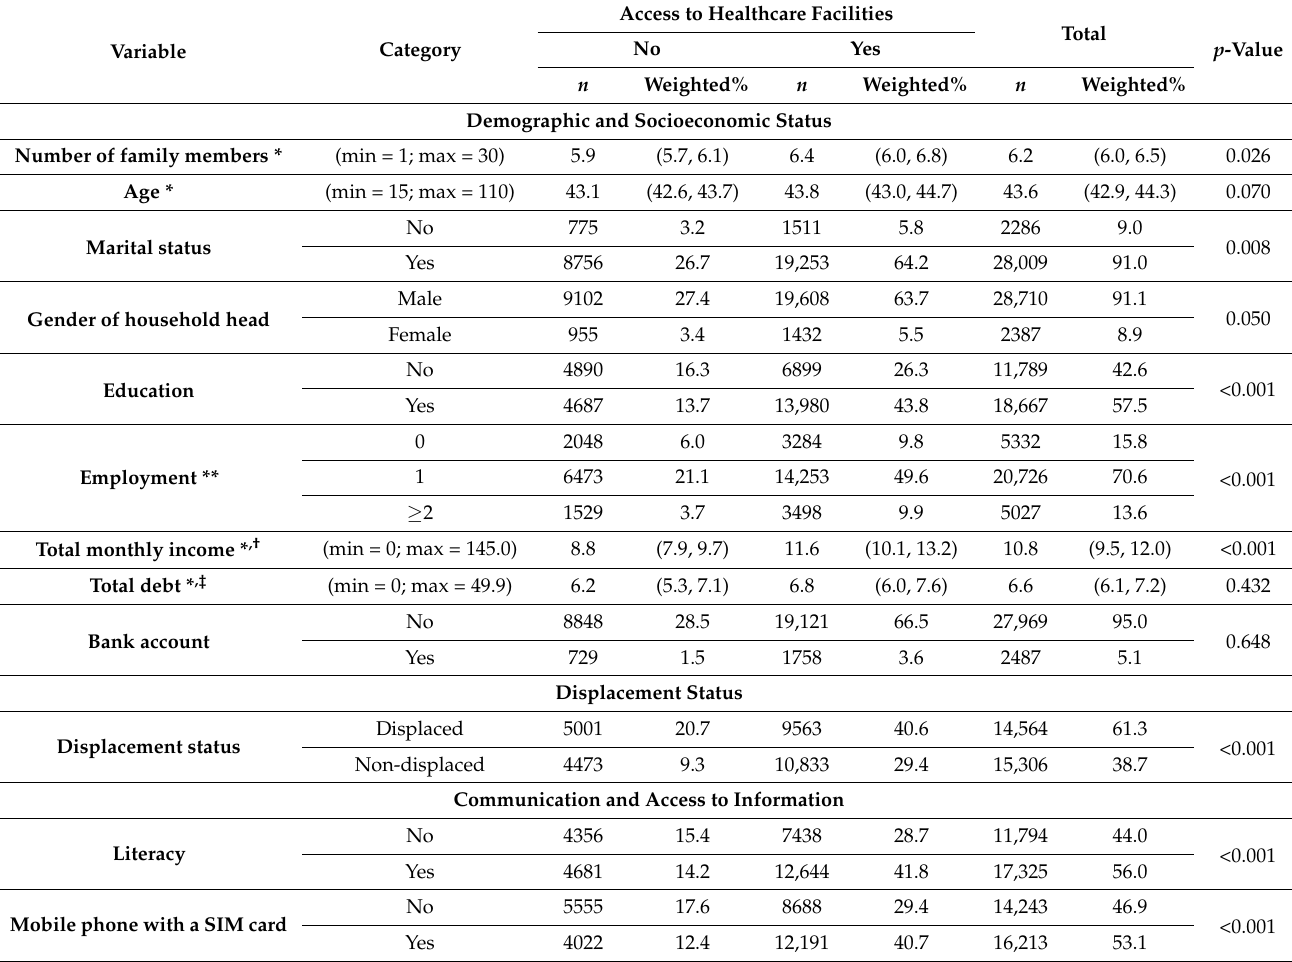
Table 1. Characteristics Afghanistan crisis-affected households by healthcare facility